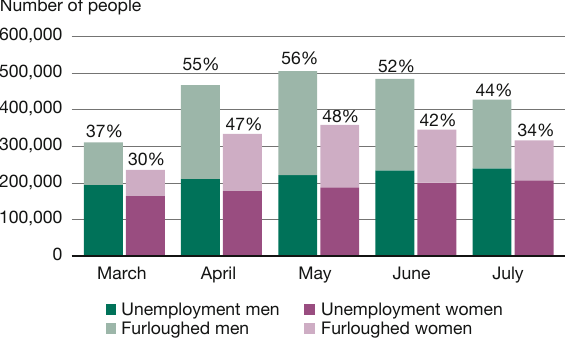
80 Jan. Feb. Mar. Apr. May Jun. Jul. Aug. Sep. Oct. Nov. Source: Labor Force Survey, Statistics Sweden.